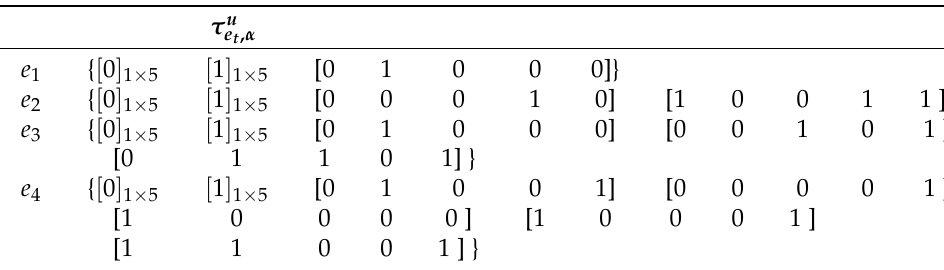
Table 4. α -Upper- e t topology; α = [ α 1 , α 2 ] , t = 1, . . . ,4.